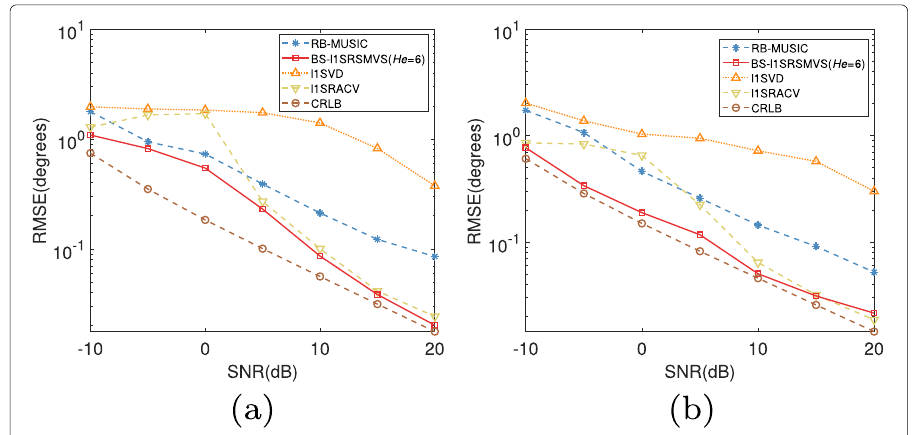
Fig. 5 RMSEs versus SNR with RB-MUSIC, BS- (cid:2) 1 -SRSMVS, (cid:2) 1 -SVD, (cid:2) 1 -SRACV and CRLB. a M =13, N =500. b M =13, N